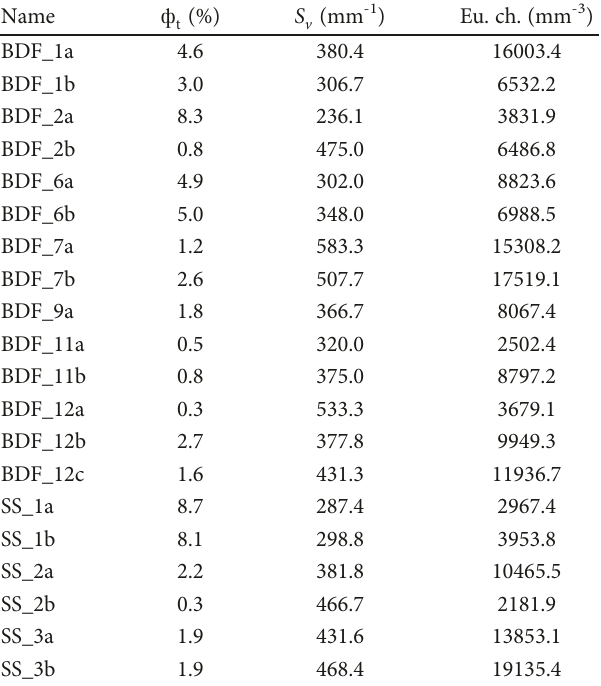
Table 4: Results X-ray microCT 3D analysis of the pore